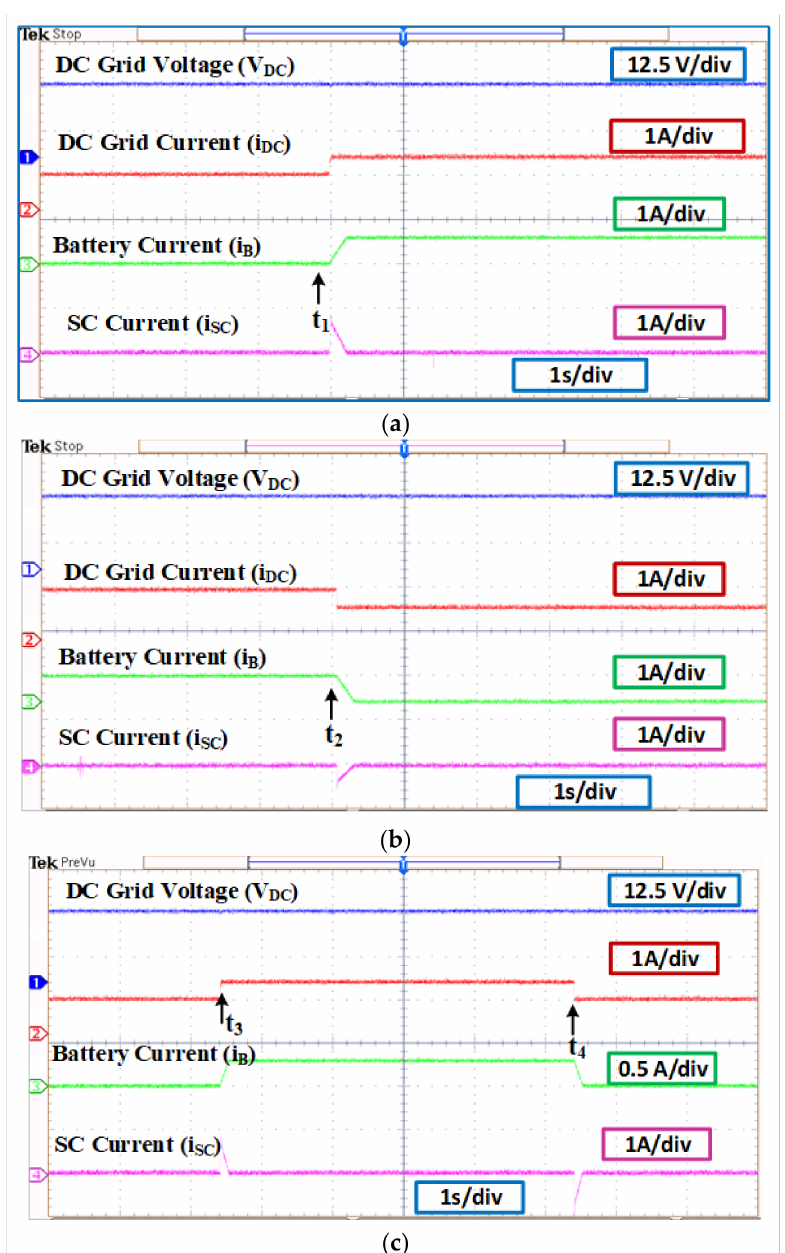
Figure 20. Experiments on a step change in load demand yielded the following findings: ( a ) step increase in load demand, ( b ) step decrease in load demand and ( c ) step increase and decrease in load